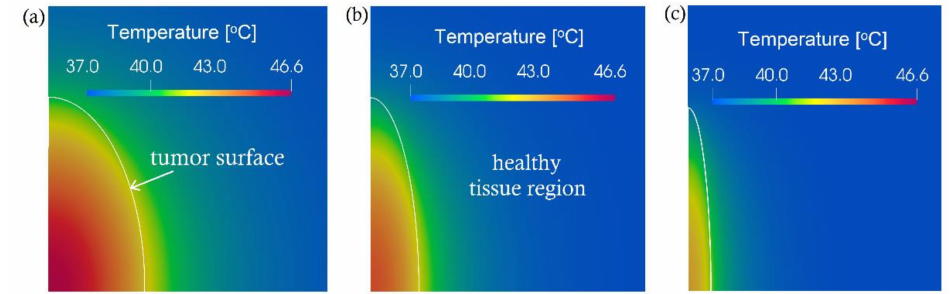
Figure 6. Treatment temperature field after 22 min of heating for prolate spheroidal tumor shapes with different aspect ratios. ( a ) AR = 2, ( b ) AR = 4 and ( c ) AR = 8.